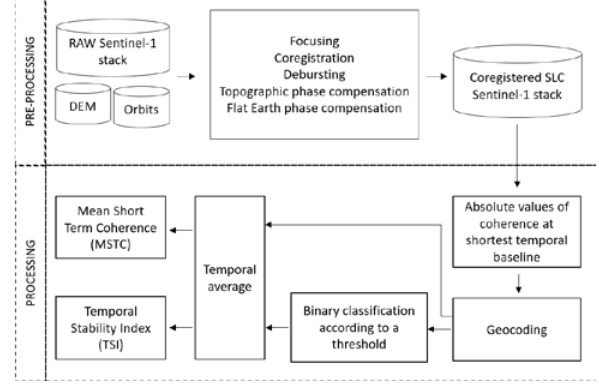
Figure 1. Scheme of the complete procedure to obtain the Temporal Stability Index from a stack of Sentinel-1 imagery.